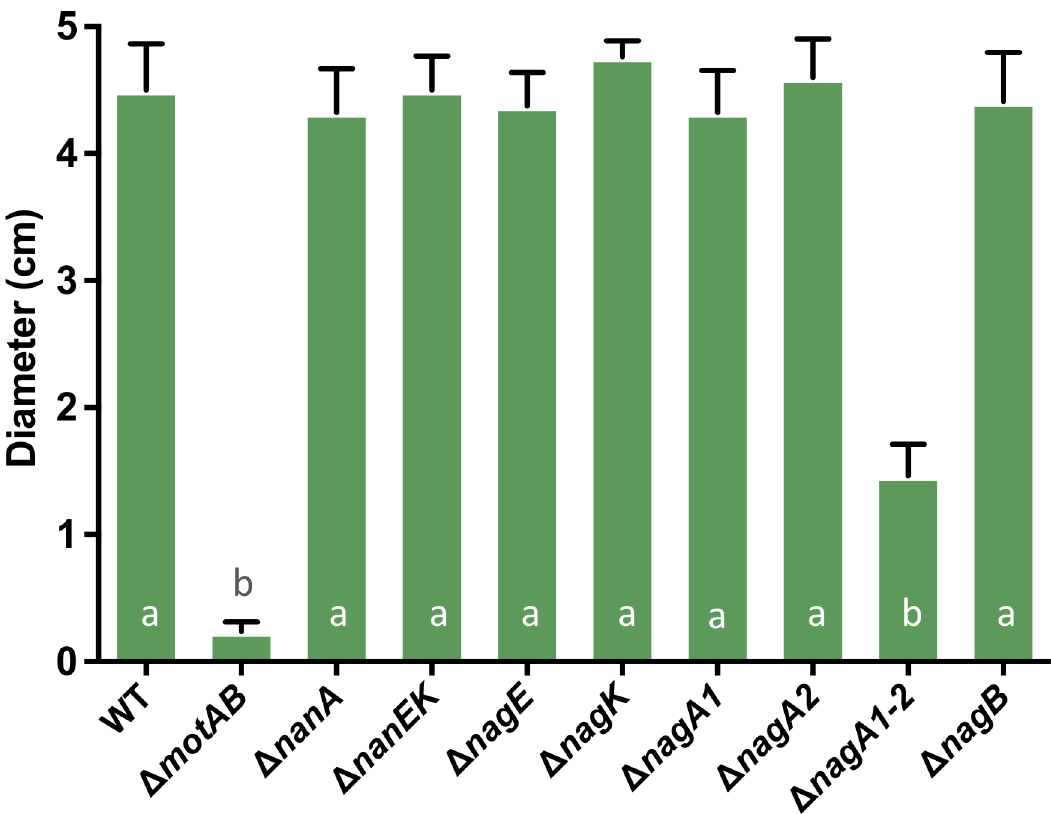
Fig 4. Motility V . cholerae mutants in the presence of mucin. The motility responses of different mutants involved in the catabolism of Neu5Ac and GlcNAc were tested on soft agar plates containing 0.1% glycerol supplemented with 0.01% mucin. Columns represent the mean of four independent experiments and error bars the standard deviation. Statistical comparisons were made using one-way ANOVA and comparing diameters of the mutants relative to wild-type using Tukey’s HSD test; bars within a panel with the same letter are not significantly different at alpha = 0.05. Bars with the letter a are not significantly different at alpha = 0.05 from one another but are different from b at P <